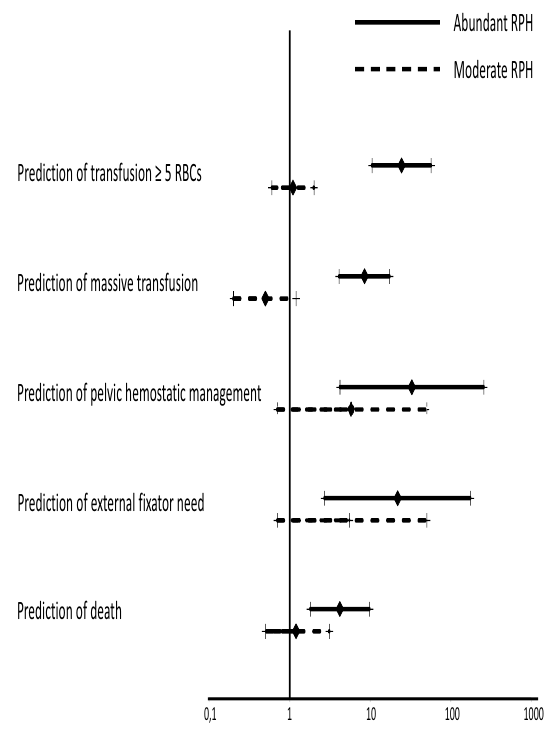
Figure: AbilityofRPHscoretopredicttransfusionrequirements,pelvichemostaticmanagementandoutcome. F‑39 Early post traumatic pulmonary embolism in intensive care unit Mariem Dlela ( speaker ), Abir Bouattour, Olfa Turki, Hela Kallel, Mabrouk Bahloul, Hédi Chelly, Mounir Bouaziz Hbib bourguiba university hospital, Sfax,